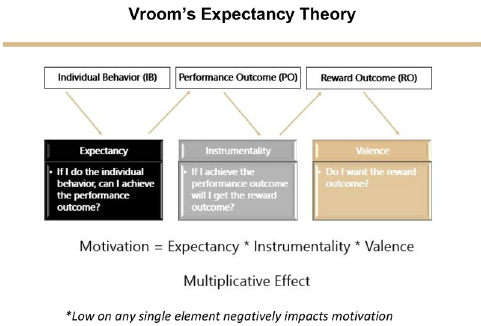
Figure A2. Vroom ’ s expectancy